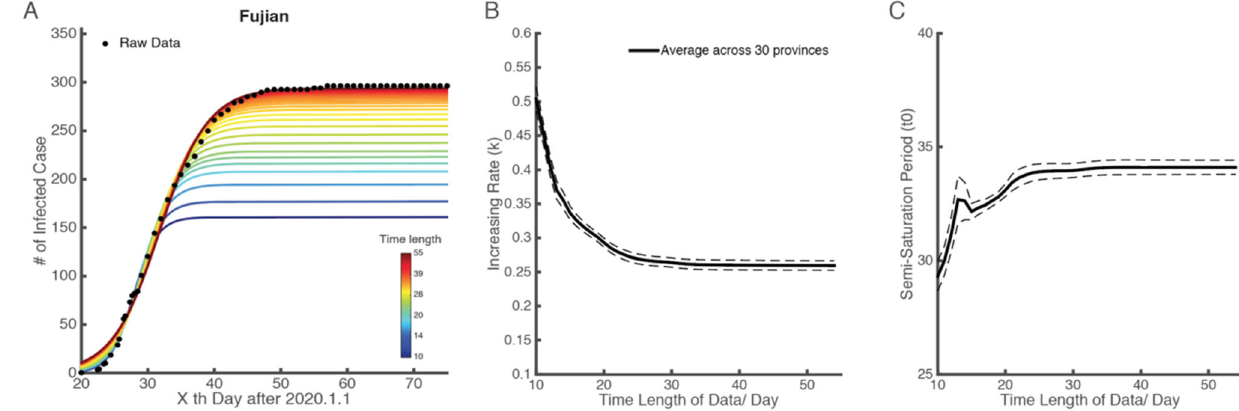
Fig. 4 Time stability of the logistic model for COVID-19 infected cases in China’s